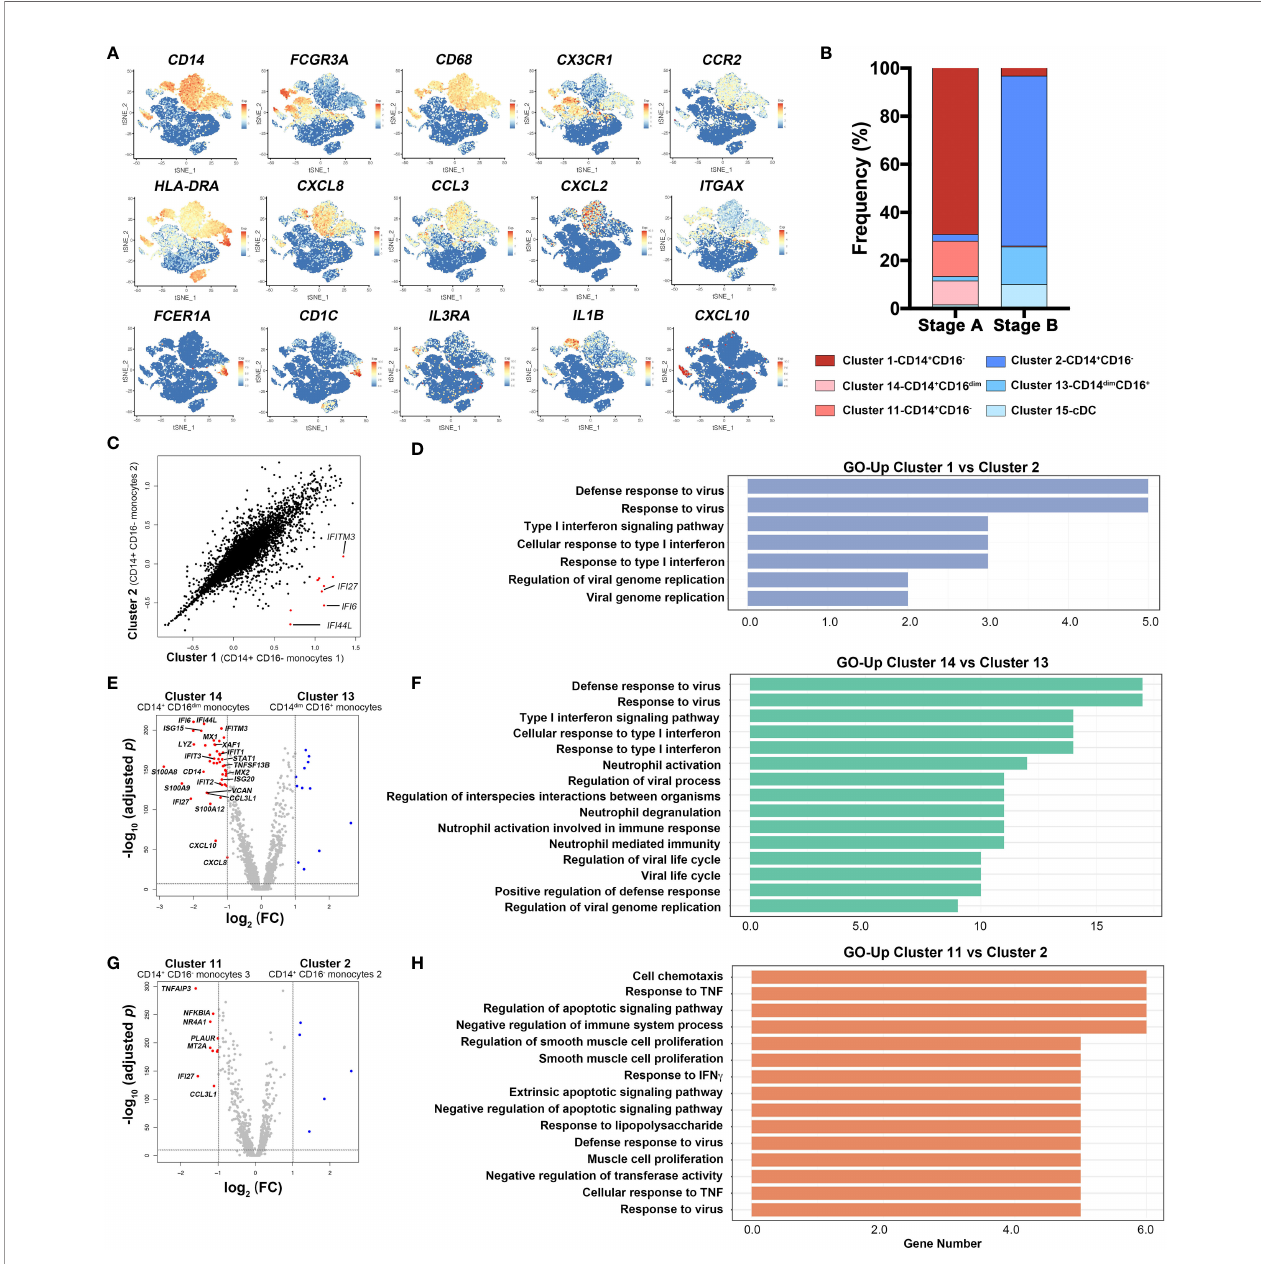
FIGURE 2 | Dynamic features of monocytes in COVID-19 patients. (A) Feature plots of characteristic genes were represented via tSNE. The relative gene expression is shown from blue to red. (B) Frequency distribution of six myeloid cell clusters, i.e., Cluster 1 (CD14 + CD16 − monocytes 1), Cluster 2 (CD14 + CD16 − monocytes 2), Cluster 11 (CD14 + CD16 - monocytes 3), Cluster 13 (CD14 dim CD16 + monocytes), Cluster 14 (CD14 + CD16 dim monocytes 4), and Cluster 15 (cDCs), in each stage. (C) Scatter plot of genes expression in Cluster 1 (CD14 + CD16 − monocytes 1) and Cluster 2 (CD14 + CD16 − monocytes 2). Differentially expressed genes in Cluster 1 are highlighted as red dots. (D) . GO analysis with genes highly expressed in Cluster 1 comparing with Cluster 2. (E) Volcano plots of Cluster 14 (CD14 + CD16 dim monocytes) versus Cluster 13 (CD14 dim CD16 + monocytes). (F) GO analysis with genes highly expressed in Cluster 14 comparing with Cluster 13. (G) Volcano plots of Cluster 11 (CD14 + CD16 − monocytes 3) versus Cluster 2 (CD14 + CD16 − monocytes 2). (H) GO analysis with genes highly expressed in Cluster 11 comparing with Cluster 2. Differential expressed genes were de fi ned with threshold of fold change ≥ 2 and p-value <0.05 and represented as red or